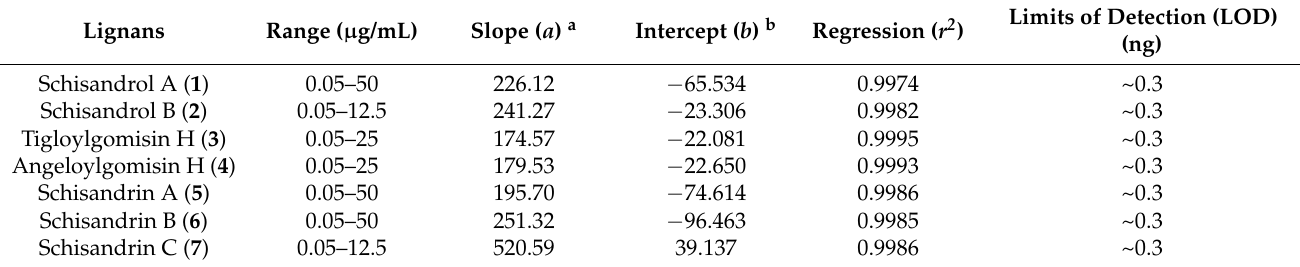
Figure 1. Chemical structures of seven dibenzocyclooctadiene-type lignans ( 1 – 7 ). 1 , schisandrol A; 2 , schisandrol B; 3 , tigloylgomisin H; 4 , angeloylgomisin H; 5 , schisandrin A; 6 , schisandrin B; 7 , schisandrin C. Table 1. Linear ranges and correlation coefficients of calibration curves.